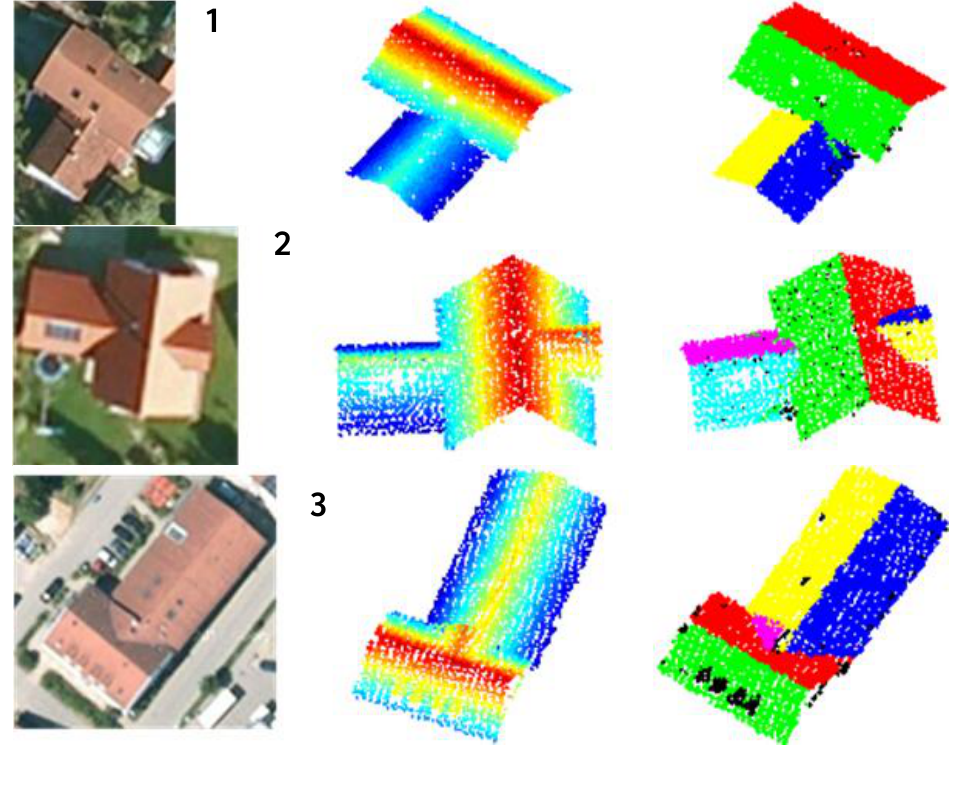
Figure 6. Segmented roof, from left to right: aerial photo, roof point cloud sorted by height, and segmented roof (noise points with black